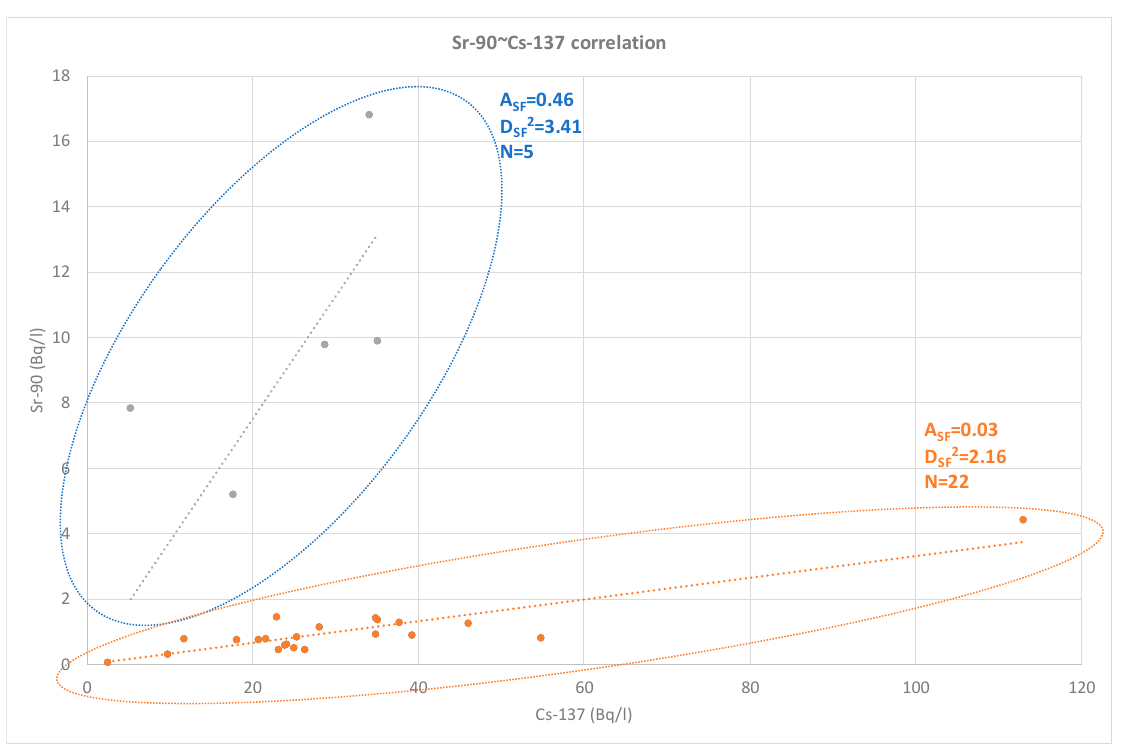
Figure 4. Sr-90~Cs-137 correlation in the Trino “E. Fermi” nuclear power plant’s liquid effluents.